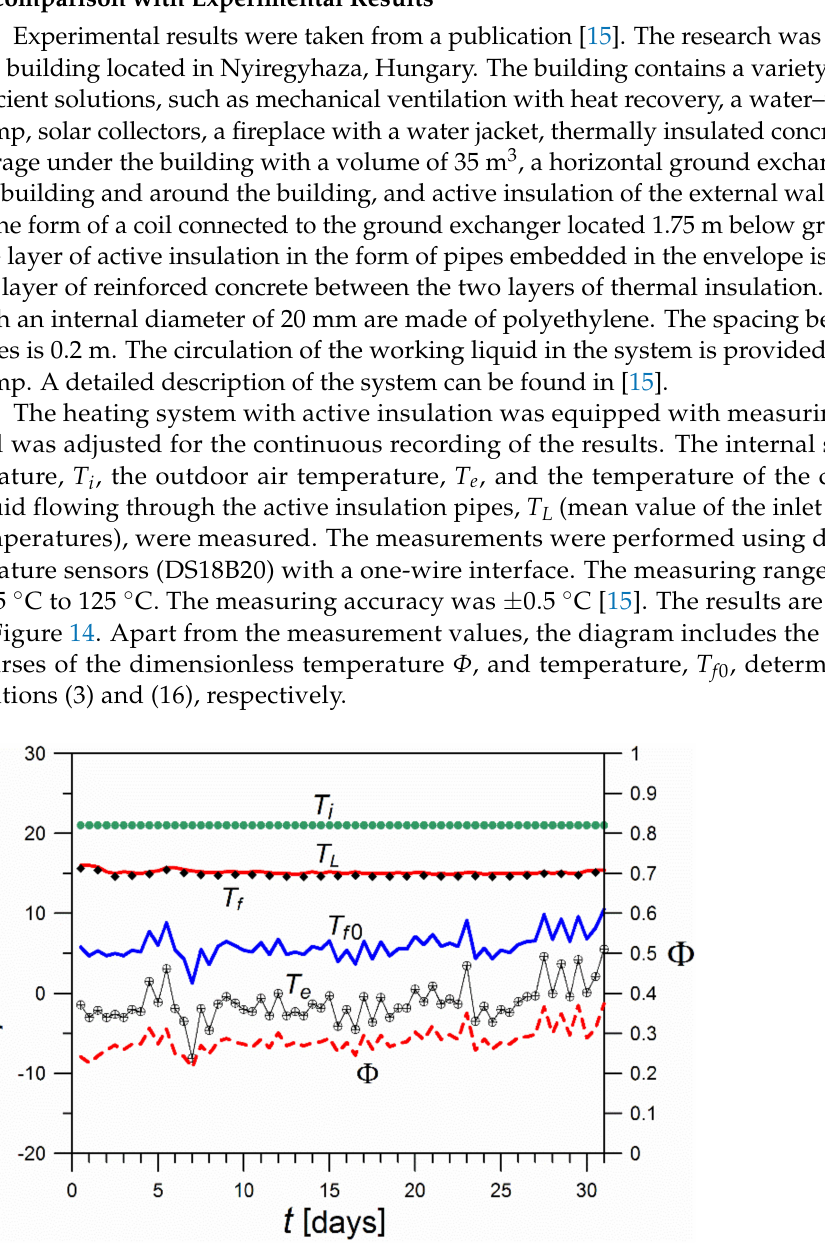
Figure 14. Temporal courses of the internal space temperature, T i , mean working liquid temperature, T L , and the ambient temperature, T e —measurement